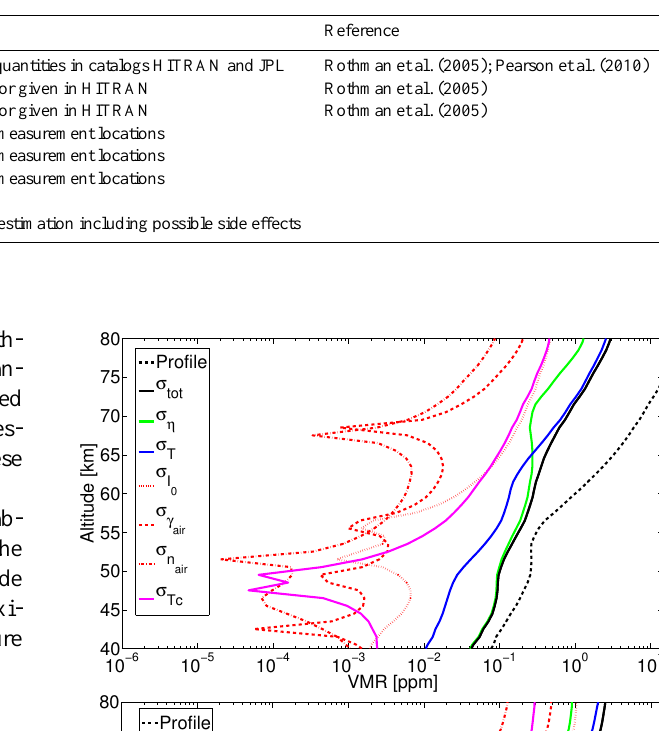
Table 2. Considered error contributions. See text for further justification.